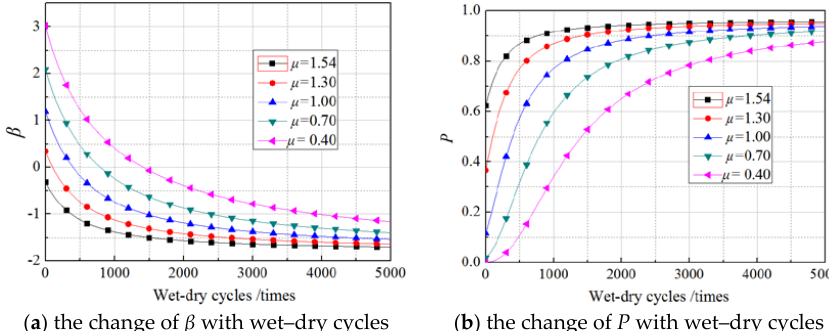
Figure 6. The effects of mean of the load on the nonsustained loading specimens. Materials 2018 , 11 , x FOR PEER REVIEW